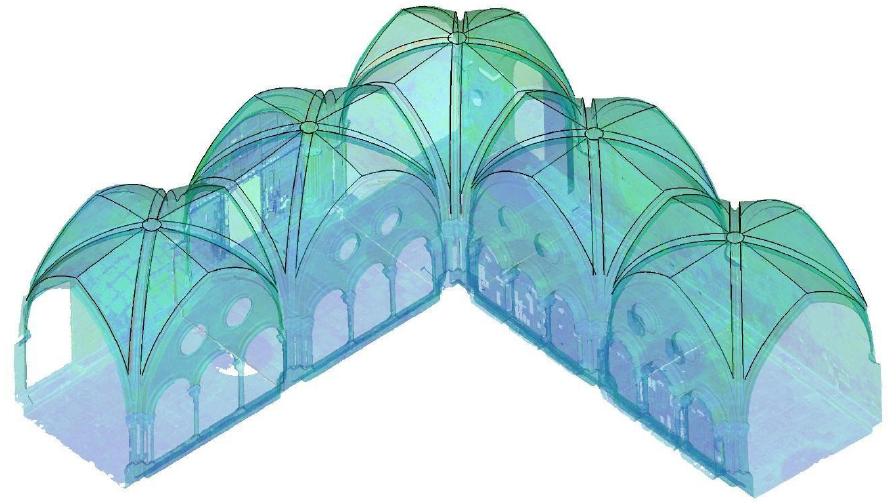
Figure 4. Mesh of the north corner of the cloister of the Cathedral of Tarragona.